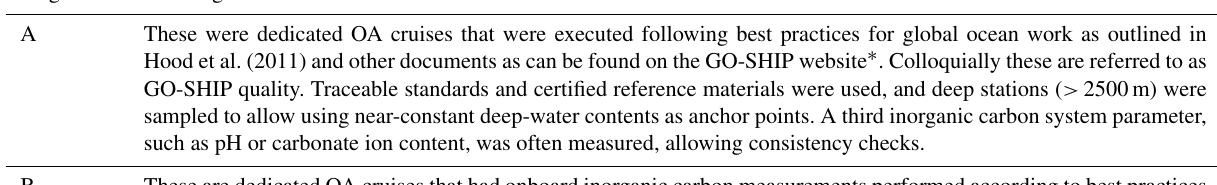
Table 3. Cruise flags used for this product. Flag value